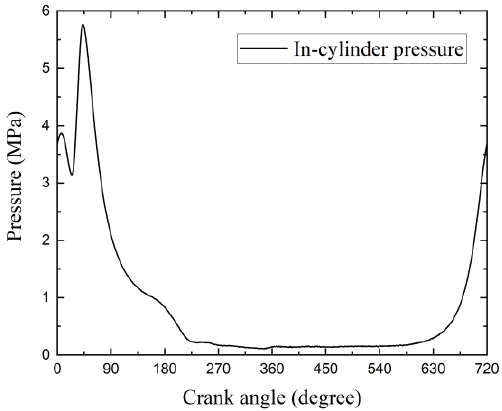
Figure 8. In-cylinder pressure at 2500 rpm under the wide open throttle (WOT) condition.